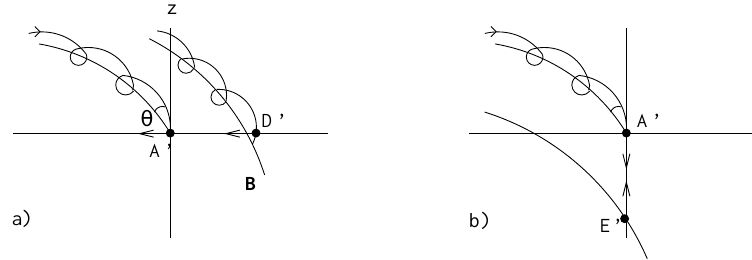
Fig. 4. Problem Geometry. The magnetic field has an magnetic dip angle θ at the observation point A 0 . The axis z represents the vertical axis and the abscissa is the horizontal.